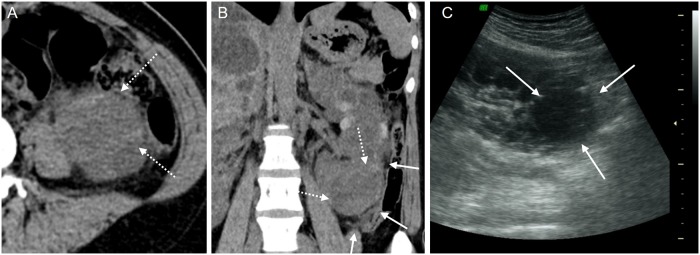
A 65-year-old female patient with an infected cyst (R10 in Fig 2).(A, B) Pre-contrast CT image shows a 4.5 cm sized cyst with a lobulated shape in left kidney lower pole (dotted arrows). The cyst has pericystic infiltration (arrows). (C) On US scan, the cyst (arrows) appears heterogeneous and echogenic.